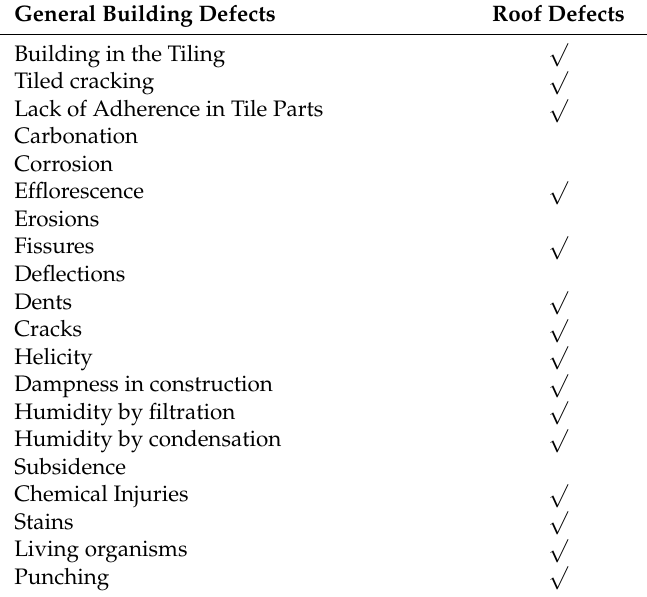
Table 1. Defects in roofs and in their protective